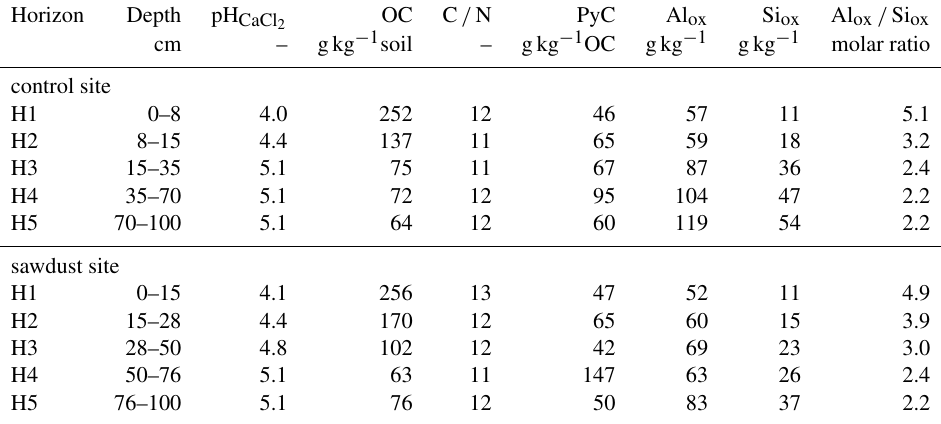
Table 2. Selected properties of bulk samples used in the sequential density fractionation. The soil profiles were selected on the basis of having five horizons within the upper 1m, largest OC concentration in horizon one, similar amount of acid–oxalate-extractable elements, and having different bulk OC concentrations in the third horizon. Presented are bulk organic carbon (OC) concentrations, carbon-to-nitrogen ratios (C / N), and pyrogenic carbon (PyC) contents normalized to bulk soil OC. Al ox , Si ox , and Fe ox are the concentrations of ammonium- oxalate-oxalic-acid-extractable aluminium, silicon, and iron. The concentrations of Al, Si, and Fe are normalized to the mineral part (or inorganic part) of the dry soil assuming that the mass of OM is 2 times the mass of OC (Sollins et al.,